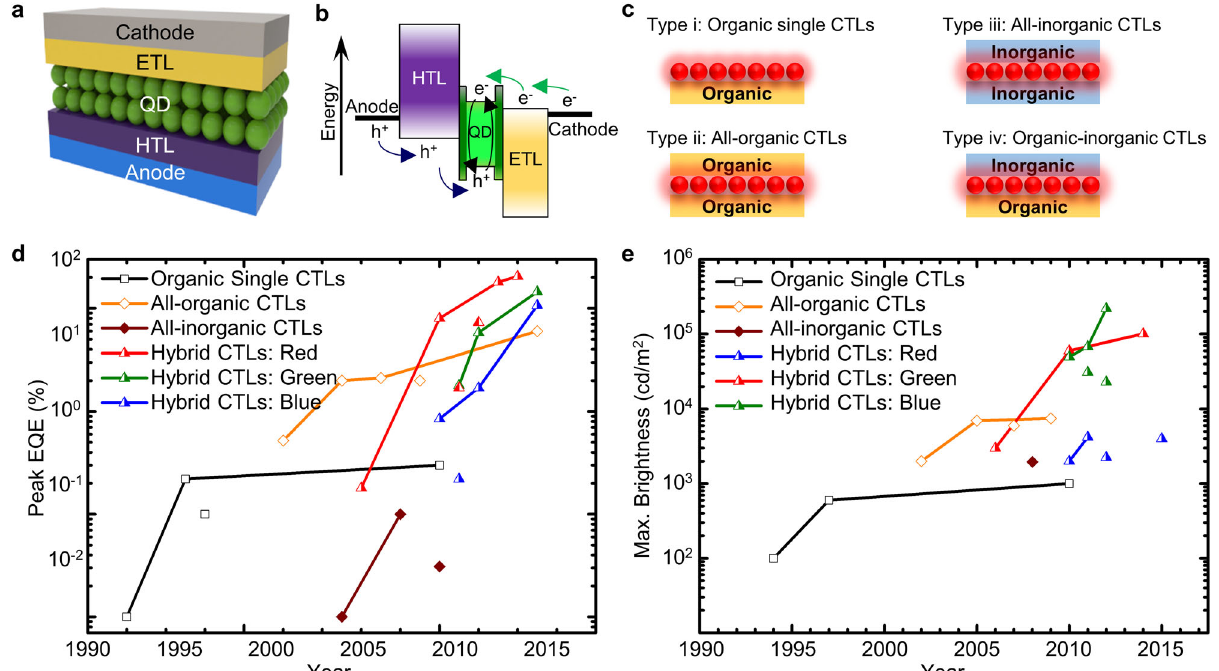
Fig. 3 Device structure and operation principles of QLEDs. a Representative device structure of quantum dot light-emitting diodes (QLEDs). b Energy diagram of a typical QLED showing charge injections from the anode and cathode. c Four representative device types of QLEDs according to the type of charge transport layer (CTL): (i) organic polymer CTL, (ii) all-organic CTL ( e.g. , TPD and TPBi), (iii) all inorganic CTL ( e.g. , n -type and p -type GaN), and (iv) organic ( e.g. , TFB) – inorganic ( e.g. , ZnO) CTL. d , e Progress in the performance of QLEDs in terms of peak external quantum ef fi ciency (EQE) ( d ) and maximum brightness ( e ). The data are categorized according to the type of CTL (From type (i) to (iv) in c ). Data for d are taken from references. (i) organic single CTLs: 76, 77, 78, 110, (ii) all-organic CTLs: 79, 80, 82, 83, 84, (iii) all-inorganic CTLs: 85, 86, 88, (iv) hybrid CTLs: 52, 89, 92, 93, 94, 95, 96. Data for panel e are taken from references: (i) organic single CTLs: 76, 77, and 110, (ii) all- organic CTLs: 79, 80, 82, and 83, (iii) all-inorganic CTLs: 86, (iv) hybrid CTLs: 48, 52, 89, 92, 93, 94, and